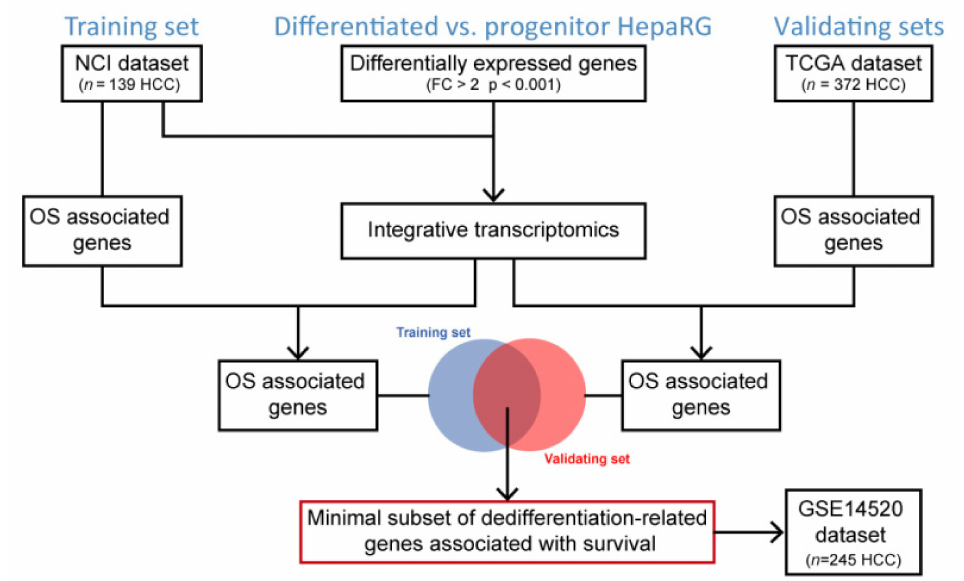
Figure 1. Flowchart of the study design. OS, overall